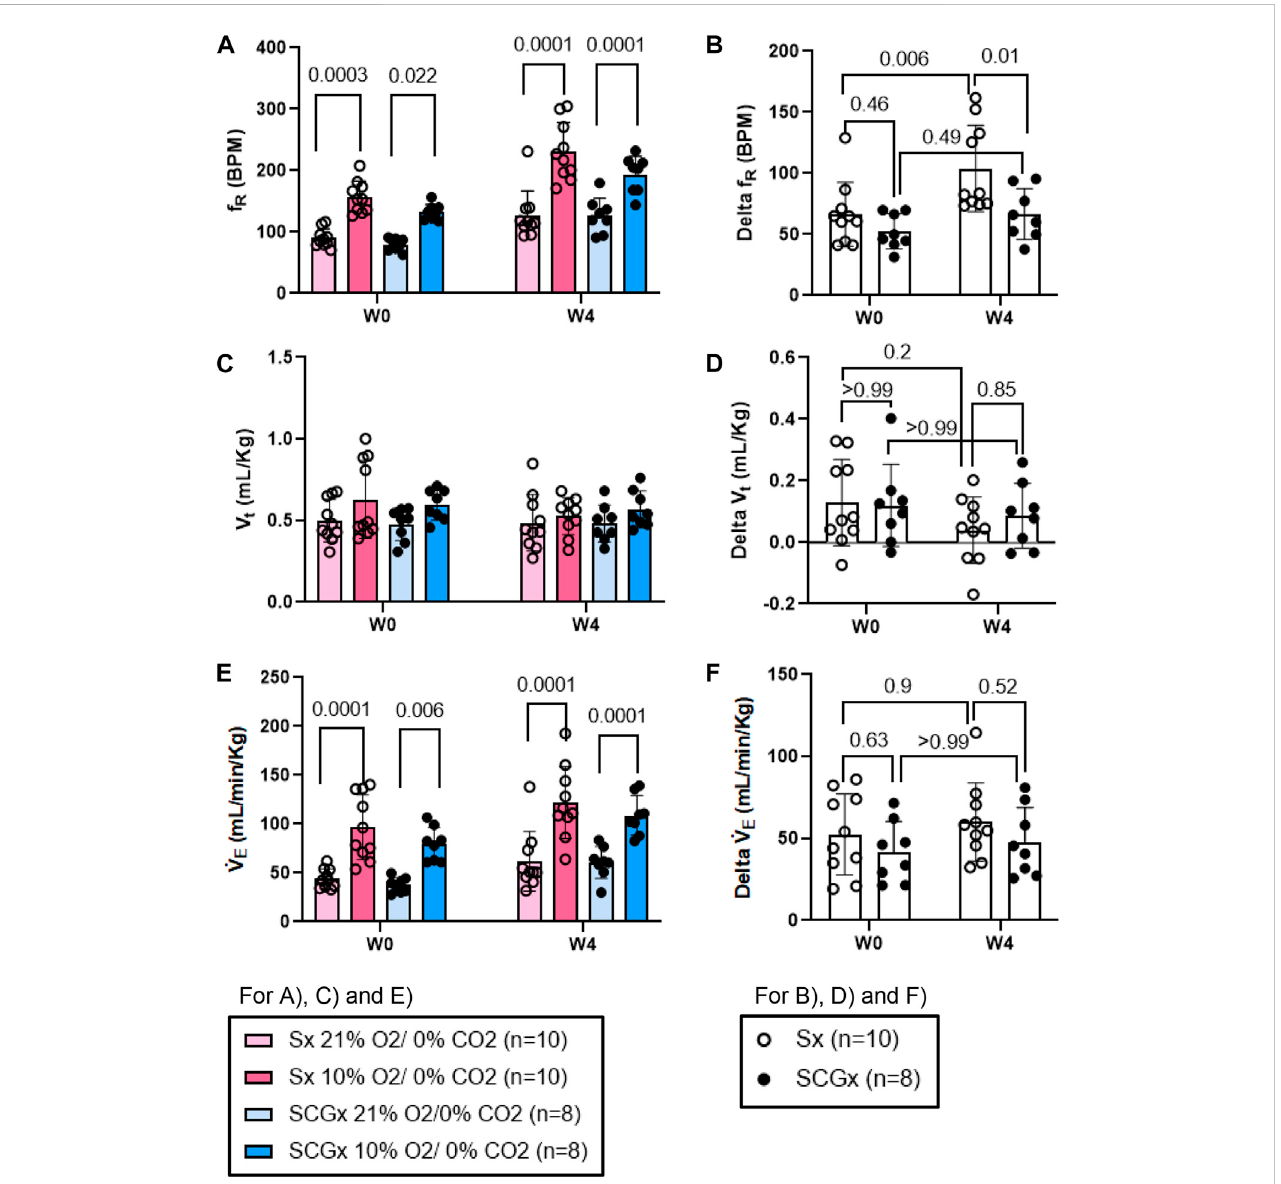
FIGURE 5 EffectofSCGx(n=8)onsensitizedchemore fl exactivityonventilatoryparametersinresponsetohypoxiaatW4post-bleo.Two-wayANOVAwasapplied usingBonferronimultiplecomparisons,Valuesaremean±SD; (A) Respiratoryrate(f R ); (B) Deltaf R ; (C) Tidalvolume(V t ); (D) DeltaV t ; (E) Minuteventilation(V _ E ); (F) Delta V _ E